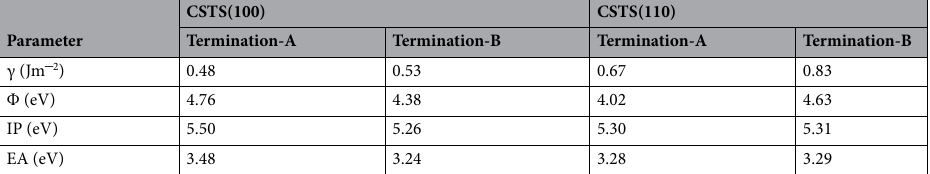
Table 2. Calculated surface energy (γ), vacuum level ( E vac ), Fermi level ( E F ), work function (Φ), Ionization potential (IP), and electron affinity of the (100) and (110) surfaces of Cu 2 SrSnS 4